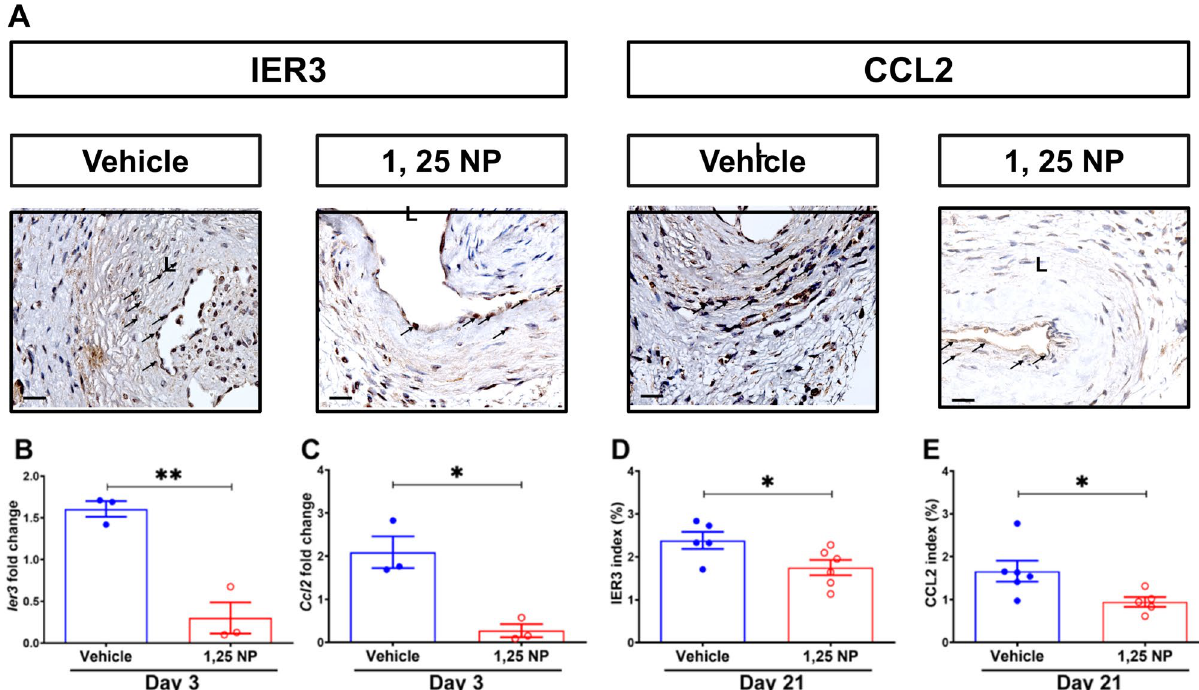
Figure 2. Decreased IER3 and CCL2 gene and protein expression in PTA plus 1,25 NP treated vessels. ( A ) Representative IER3 and CCL2 staining at day 21 in the 1,25 NP treated outflow graft veins and vehicle control veins, respectively. ( B , C ) At day 3, there was a significant decrease in the average gene expression of Ier3 and Ccl2 of 1,25 NP treated GVs compared to vehicle controls, respectively. ( D , E ) Semiquantitative analysis demonstrated significant decreases in the average IER3 and CCL2 indexes in 1,25 NP treated vessels compared to controls. Each data point in the scatter plot bar graph represents the mean ± SEM of 3–6 animals. Unpaired t- test was performed. Significant differences between groups are indicated * p < 0.05, ** p < 0.01, *** p < 0.001. Cells staining positive for IER3 and CCL2 are brown staining. L lumen, ADV adventitial; solid arrows, positive cells. Scale bar is 50